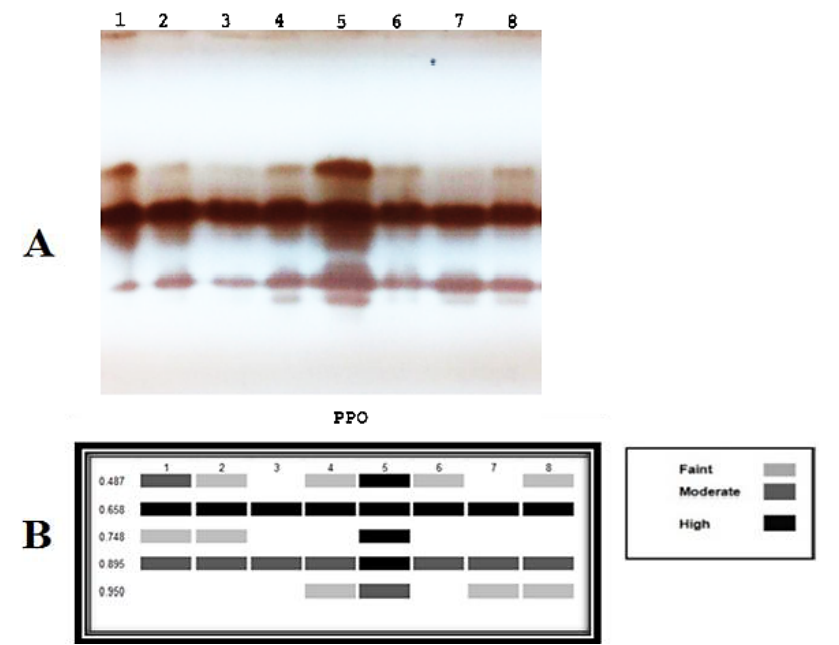
Figure 6. The effect of F. oxysporum and the application of cyanobacteria on ( A ) Polyphenol oxidase isozyme. ( B ) Ideogram analysis of PPO isozyme of the infected pepper plants. 1 = Healthy control; 2 = Infected control; 3 = Infected plant + D. muscorum (soil); 4 = Infected plant + A. oryzae (soil); 5 = Infected plant + A. platensis (soil); 6 = Infected plant + D. muscorum (foliar); 7 = Infected plant + A. oryzae (foliar); 8 = Infected plant + A. platensis (foliar).